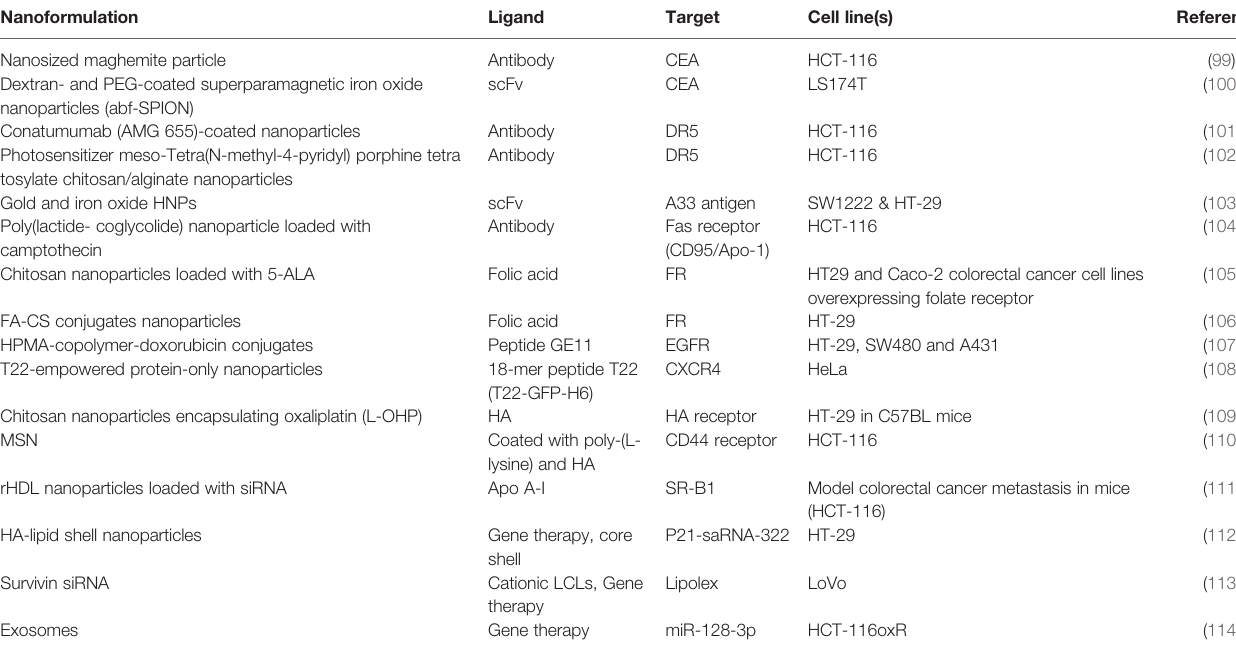
TABLE 2 | CRC inhibitors and nanoformulations.